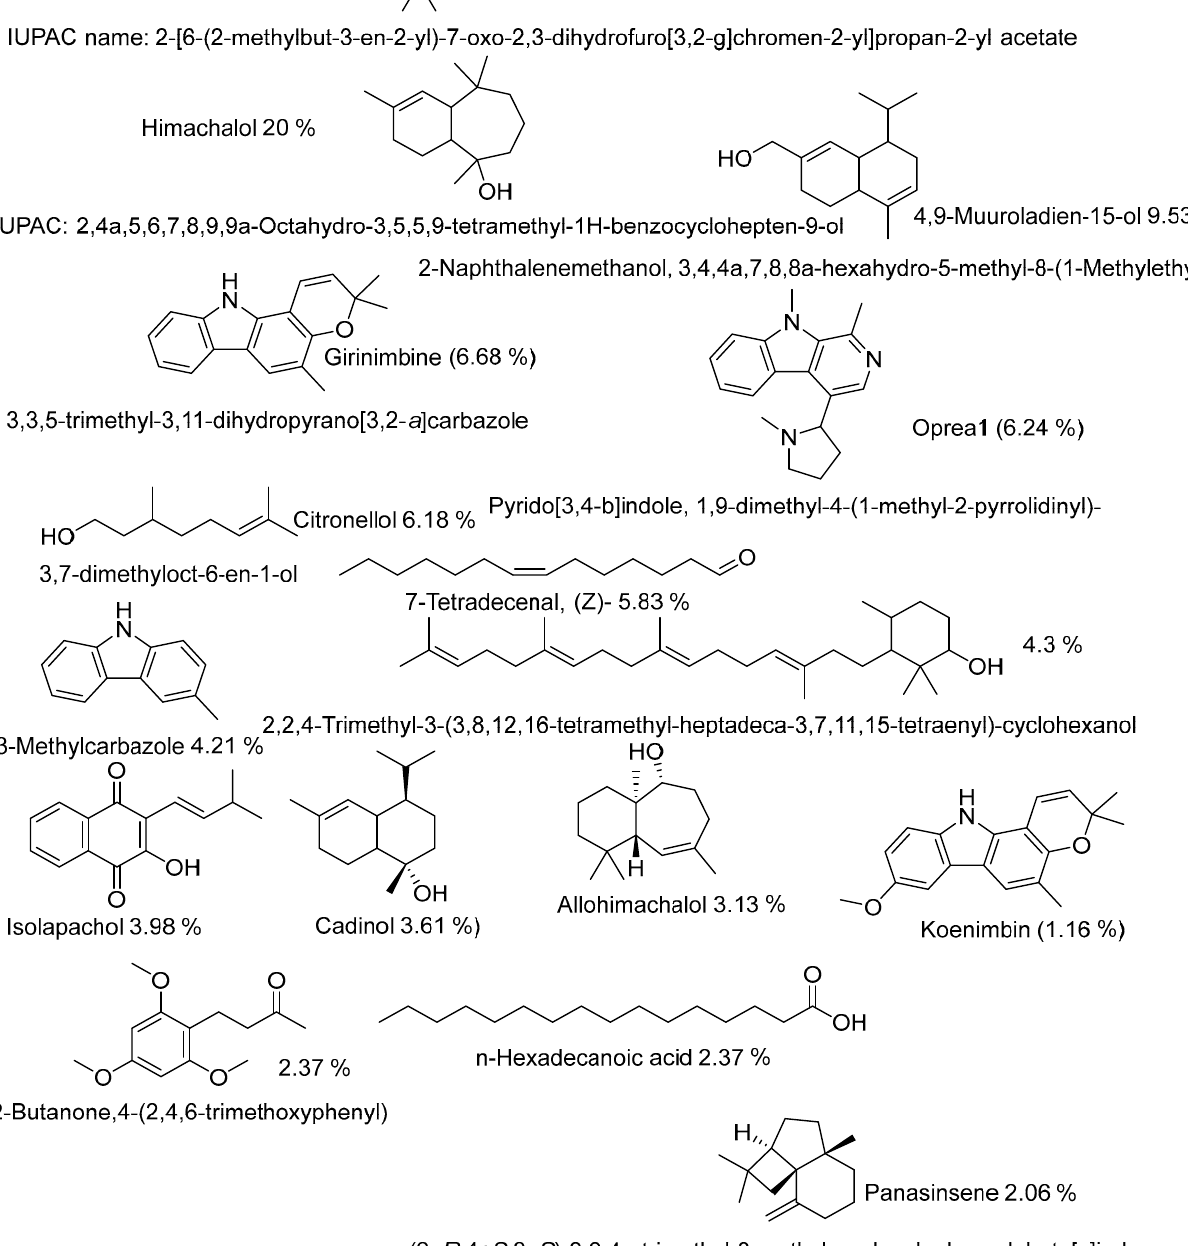
Figure 8. Structure of compounds reported for the first time in root bark non-volatile oils of genus Toona and species ciliata.